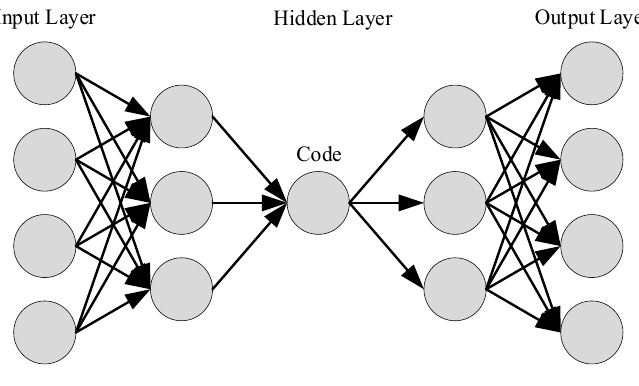
Figure 4. AutoEncoder model.